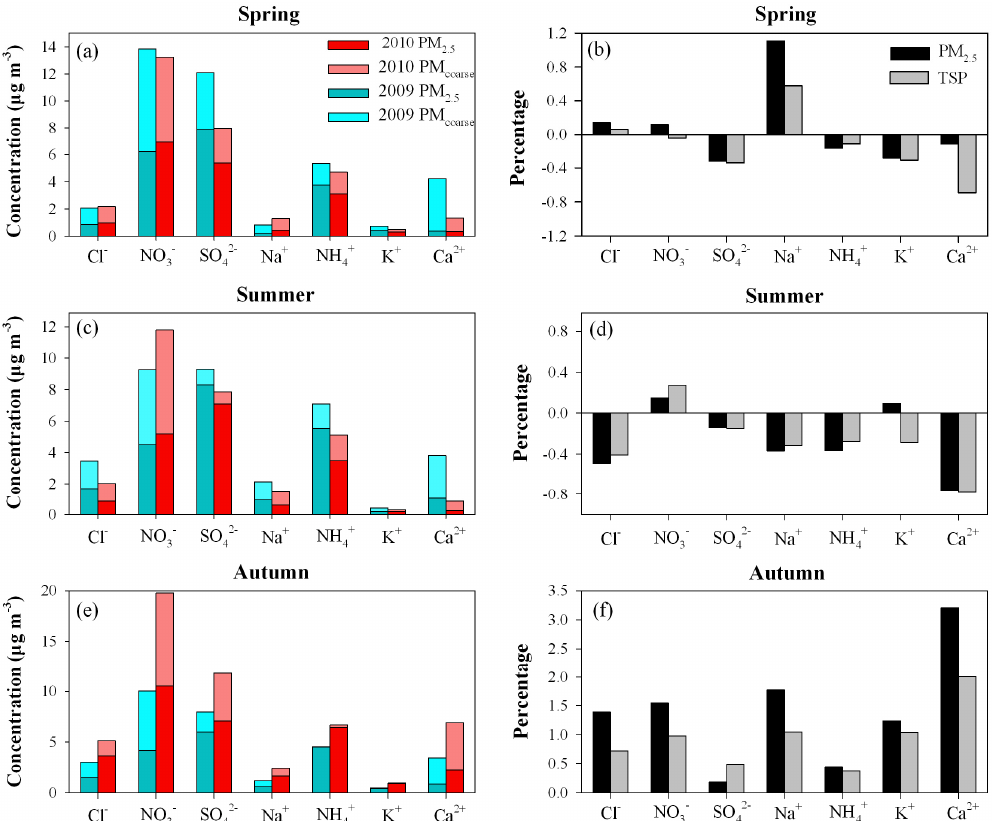
Fig. 10. (a, c, e) The seasonal average concentrations of Cl − , NO − Figure 10. (a,c,e) The seasonal average concentrations of Cl - , NO 3- , SO 42- , Na + , NH 4+ , K + , and Ca 2+ in 2010. (b, d, f) The seasonal average percentage changes of the ions referred to above in 2010 relative to PM 2.5 and TSP during 2009 and 2010. (b,d,f) The seasonal average percentage changes of the ions referred above in 2010 relative to 2009.